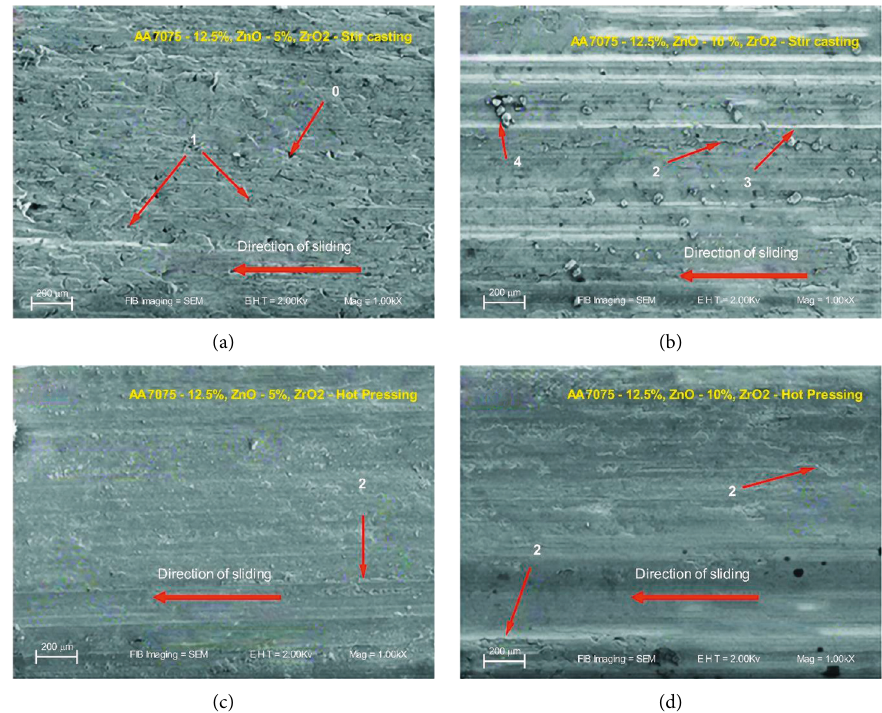
Figure 11: Wear Surface morphology of hot-pressed and stir-casting AA 7075/ZnO-ZrO stir casting. (b) AA7075-12.5%, ZnO-10%, ZrO 2 -stir casting. (c) AA7075-12.5%, ZnO-5%, ZrO 2 -hot pressing. (d) AA7075-12.5%, ZnO- 10%, ZrO 2 -hot